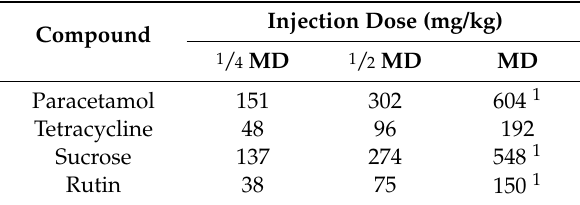
Table 2. Compound doses used for hepatotoxicity testing (yolk injection).